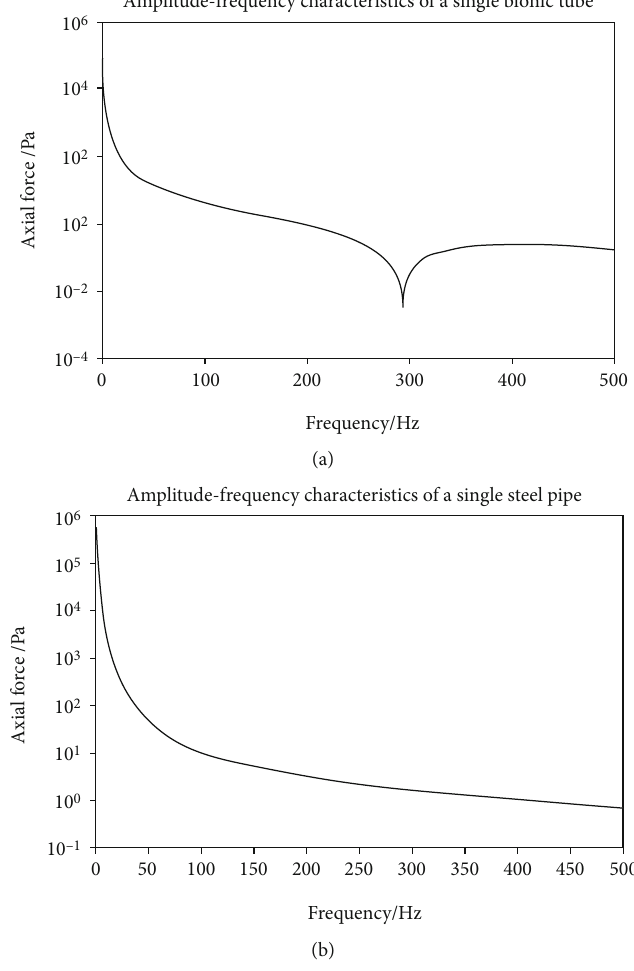
Figure 4: (a) Amplitude-frequency characteristics of bionic pipe. (b) Amplitude-frequency characteristics of stainless steel